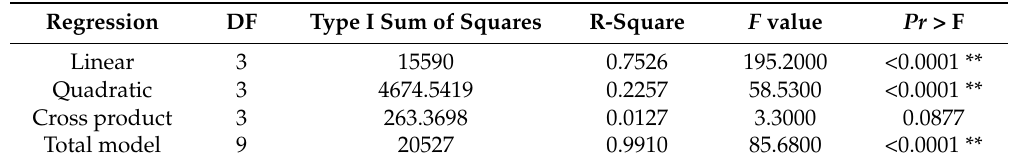
Table 4. Analysis of variance (ANOVA) for the full quadratic model for optimization of mycelial TA production in G. lingzhi